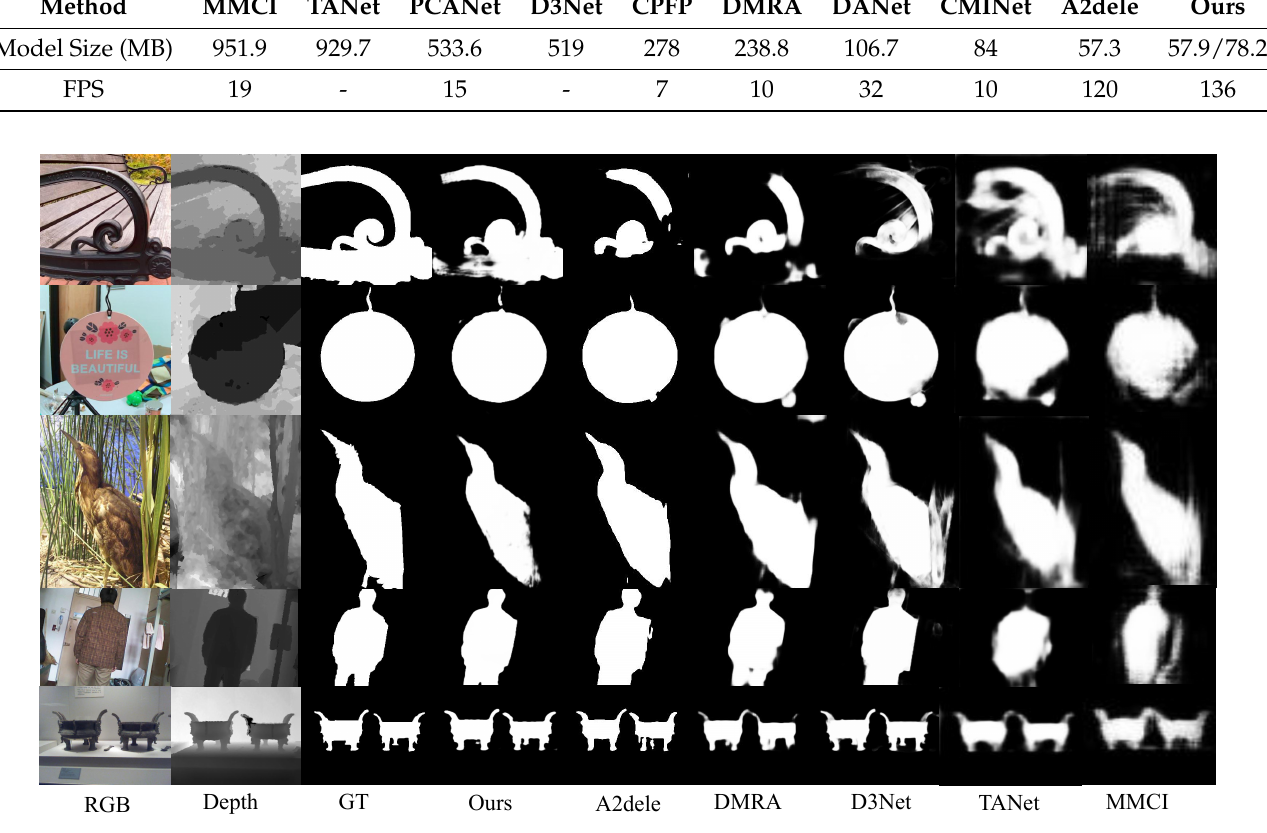
Figure 6. Visual comparisons with existing